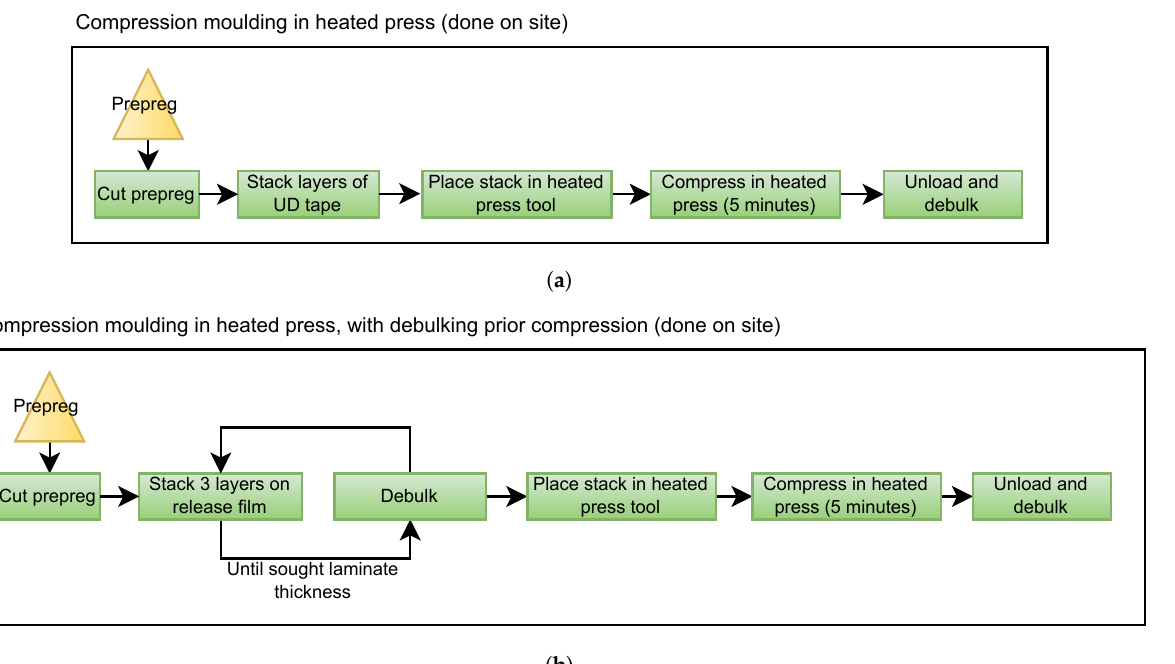
Figure 1. The flow of the different compression molding manufacturing processes used, ( a ) without debulking, and ( b ) with